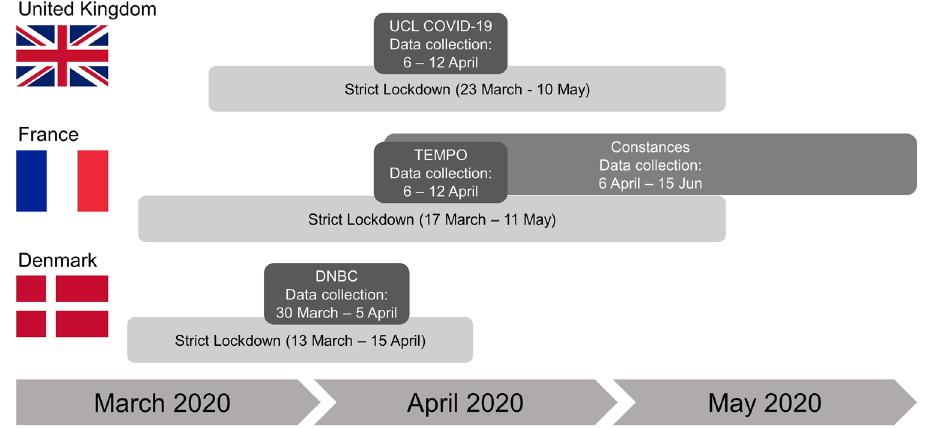
Figure 1. Data collection in the four participating